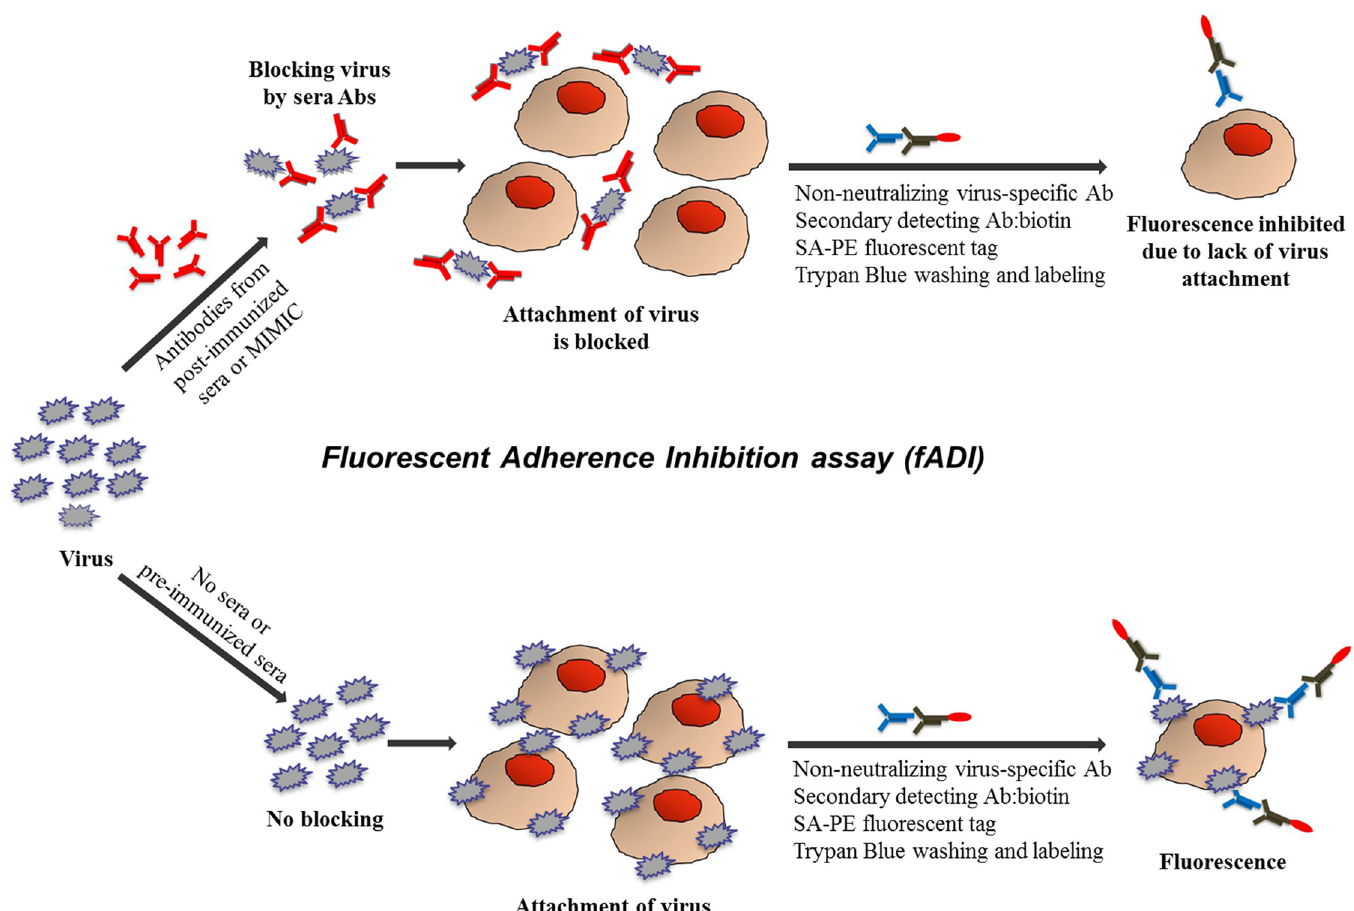
Fig 1. Schematic representation of fADI neutralization assay. Incubation of virus with sera (upper arm) or without sera (lower arm) either blocks or does not block virus attachment to target cells, respectively. Virus attached to the cells is detected by virus specific antibody and fluorescent tag SA-PE followed by additional staining cells with diluted Trypan blue and finally reading on Bioplex. The maximum fluorescent signal without serum corresponds to zero blocking, (lower arm), reduced fluorescent signal indicating blocking of the virus with serum antibody (upper arm).